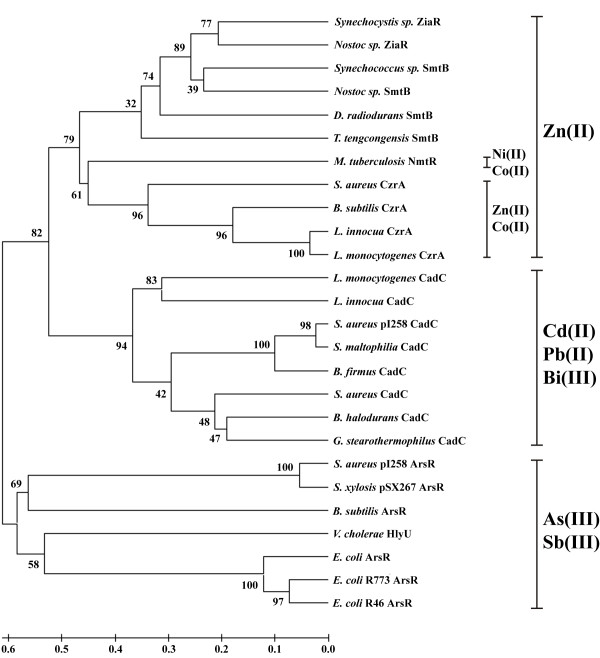
Phylogenetic relationship of SmtB/ArsR family members (25 SmtB/ArsR family members and the Vc-HlyU sequence). This is a bootstrap consensus tree based on 1000 replicates. The numbers on the nodes are bootstrap values. The metal-binding motifs sense different metals, present in the three major clusters, are indicated on the right.